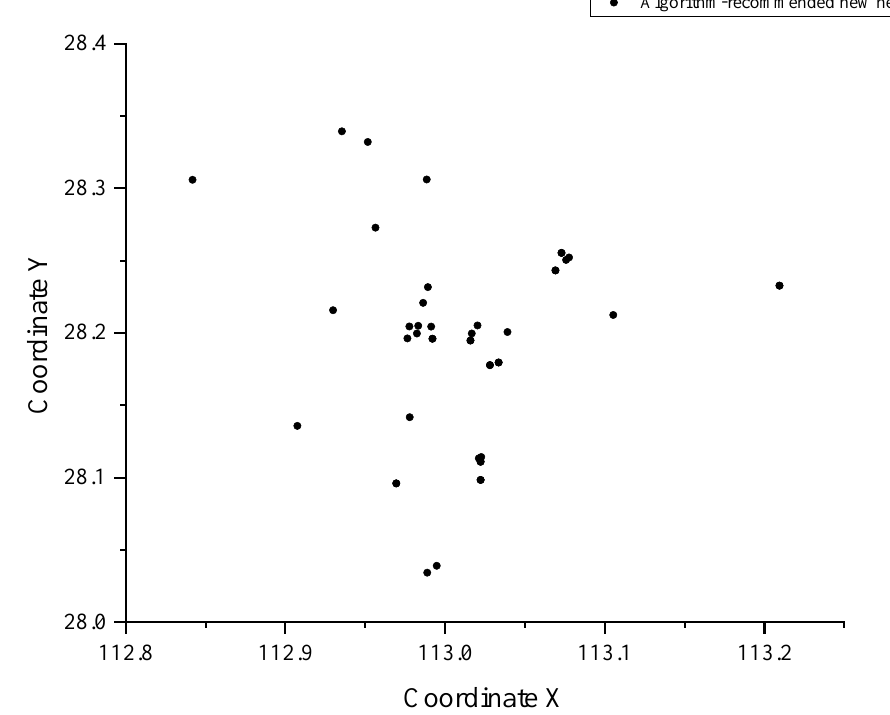
Figure 5. Distribution of demand networks in Changsha City.